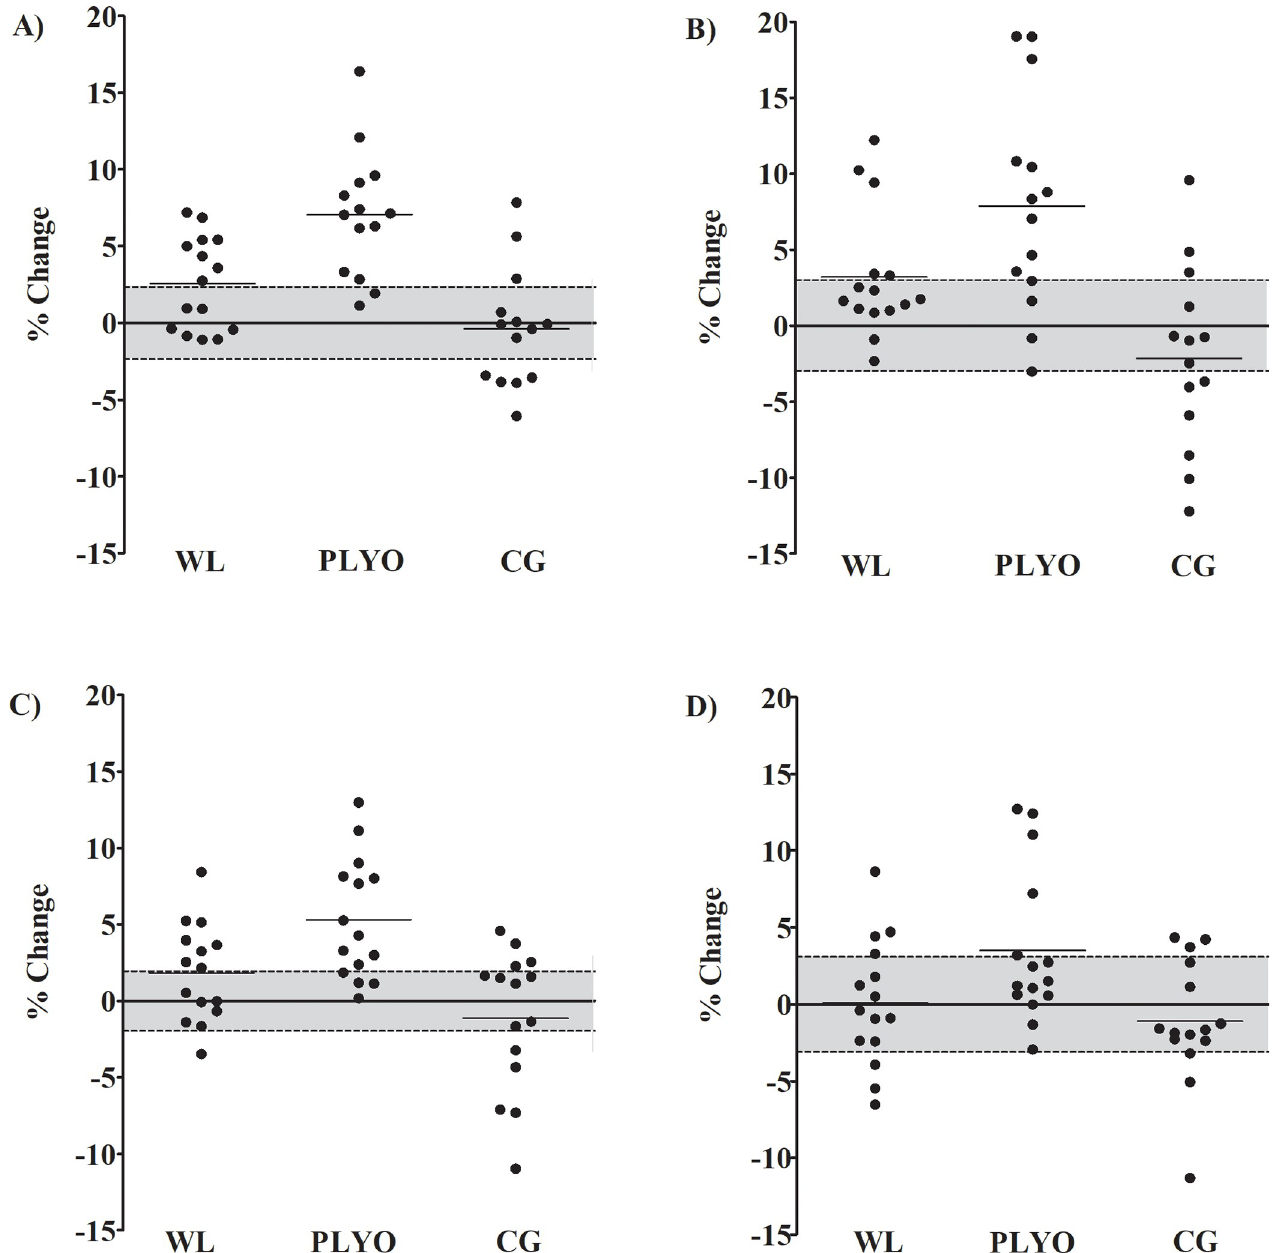
Fig 1. Unloaded vertical jumps mean (horizontal lines ____ ) and individual (black circles) percentage changes from pre- to post-training. Grey area represents the coefficient of variation (%). A) Peak power output in the squat jump, B) jump height in the squat jump, C) peak power output in the countermovement jump, and D) jump height in the countermovement jump. WL = weightlifting derivatives; PLYO = plyometric exercises; CG = control group. https://doi.org/10.1371/journal.pone.0274962.g001 group-time interaction was also observed ( p = 0.002). Jump height increased in the PLYO group at post-training ( p = 0.01, +8.9%), while no significant changes were observed in the WL group ( p = 0.56, +4.1%) and CG ( p = 0.52, -4.0%). On the other hand, for PPO and JH in the CMJ80% there were no significant group-time interactions ( p = 0.12 and p = 0.31, respec- tively). Descriptively, the percentage changes for PPO in the CMJ80% were: +3.4%, +1.6%,